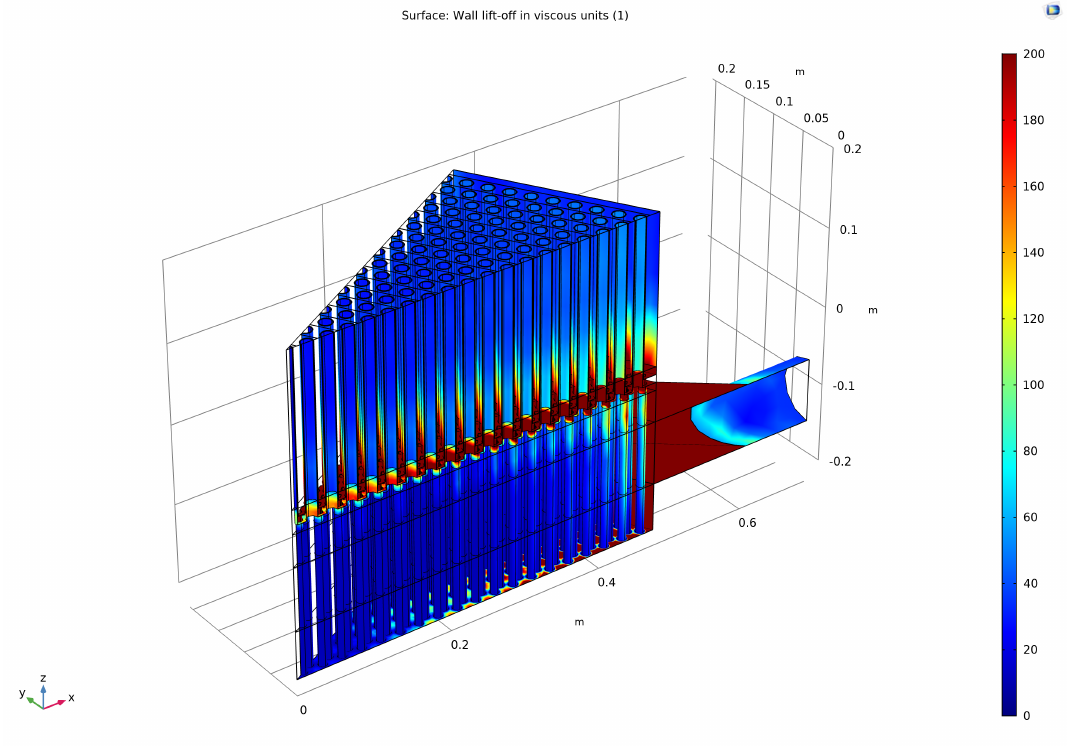
Figure 7. Wall lift-off in viscous units [1] at the wall